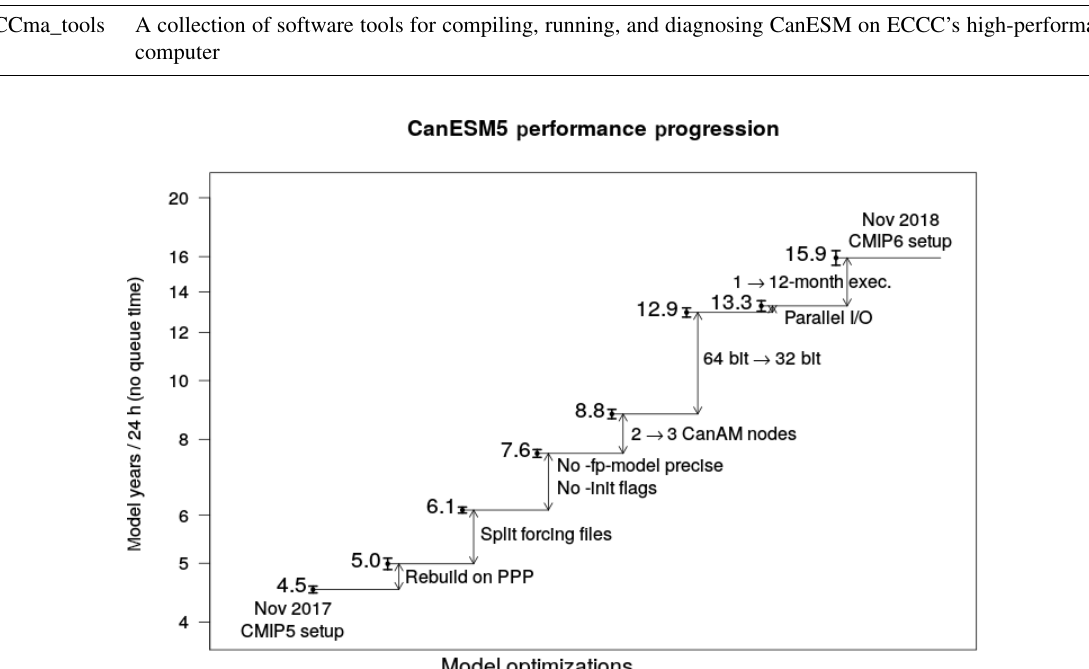
Figure 1. Schematic of CanESM5 optimization. See Sect. 3.3 and Appendix C for